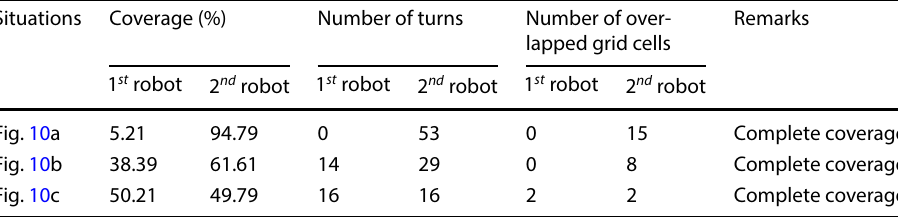
Table 7 Complete grid coverage by two mobile robots in different environmental conditions of Fig.